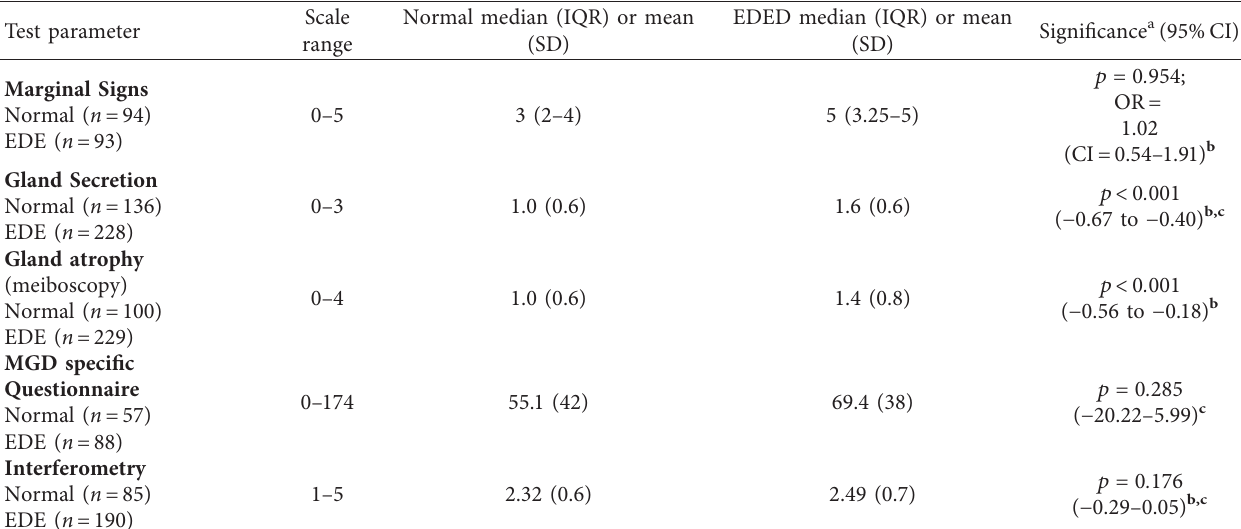
Table 2: Descriptive and inferential statistical data (OD data only); independent sample